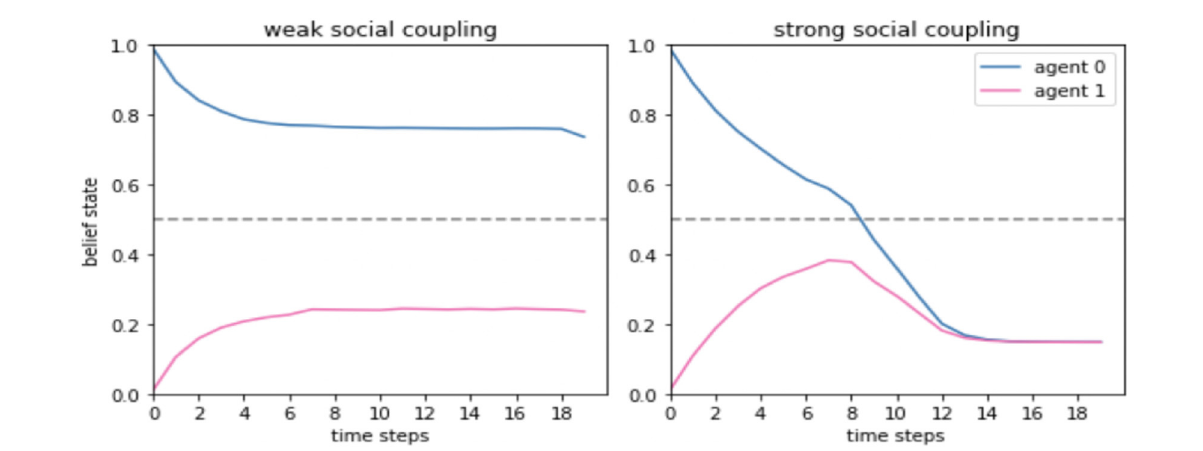
FIGURE8 Sensitivity to observable evidence modulates the level of social coupling between agents in dialogue. This Figure and its legend were adapted from an open-source preprint of a conference paper, with permission of the authors (Figure 2 of Kastel and Hesp, 2021). In our simulations, communicated cultural information takes the form of an internal belief state held by agents with a certain probability described under the A1 matrix (Figure 3A). While this internal state is defined as a binary variable, an agent’s beliefs are given by a categorical probability distribution that can take on any real number in the range (0,1). This figure shows the belief states (vertical axes) of two agents (represented in blue and pink) as they engage in dialogue across 18 time steps (horizontal axis). When the likelihood precision is low for both agents (Left) their internal states are very weakly coupled, such that each agent sticks to their own belief and does not attune to the claims of the other. In contrast, when both agents have high precisions (Right) their engagement in mutual attunement is facilitated and their beliefs converge onto one shared belief, which is then installed in both of their generative models as a shared